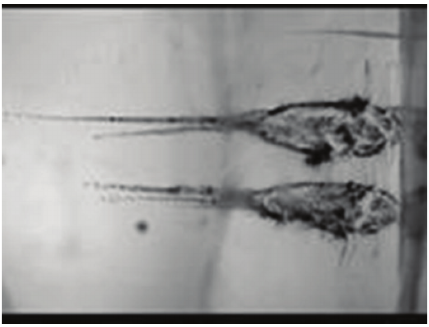
Figure 5: Comets trapped in aerogel (Image courtesy